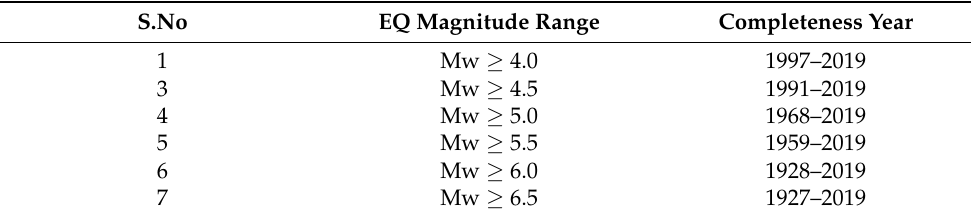
Table 1. Completeness of various magnitude earthquakes.